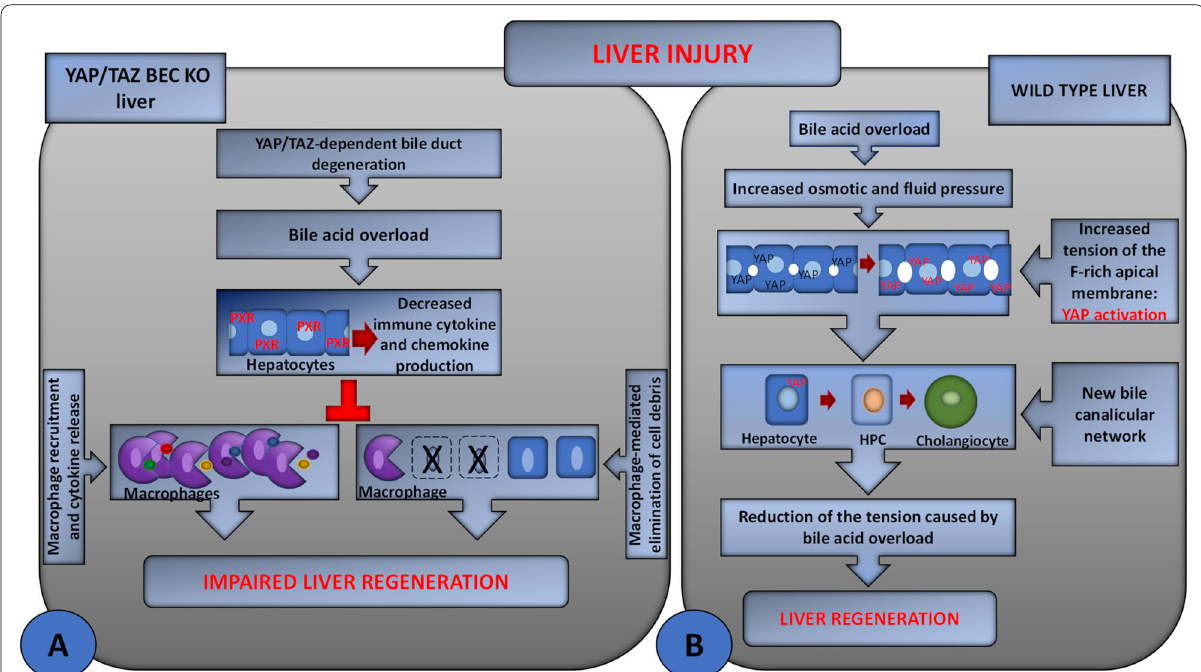
Fig. 4 Schematic representation of the role of YAP/TAZ in liver regeneration after acute tissue injury. A In YAP /TAZ BEC-KO liver severe degeneration of bile ducts causes cholestasis and has secondary effects on hepatocytes and macrophages, resulting in impaired liver regeneration. More specifically, bile acid overload is responsible for PXR-mediated suppression of cytokine production in hepatocytes, which impairs phagocytic macrophage recruitment and activation. Decreased macrophage function impairs the tissue regeneration process by reducing the clearance of cellular debris from the injury site. B In WILD TYPE liver, injury (2/3 PH)-associated bile acid overload increases osmotic and fluid pressures in the liver, resulting in higher tension of the apical membrane of hepatocytes that form the bile canalicular network. Therefore, YAP, which is localized in the F-actin-rich region of the apical membrane of hepatocytes, is activated. YAP /TAZ positively modulate liver regeneration by promoting the trans-differentiation of hepatocytes to a BEC phenotype thus contributing to liver regeneration through the formation of new bile ducts. YAP: black, inactive; red,